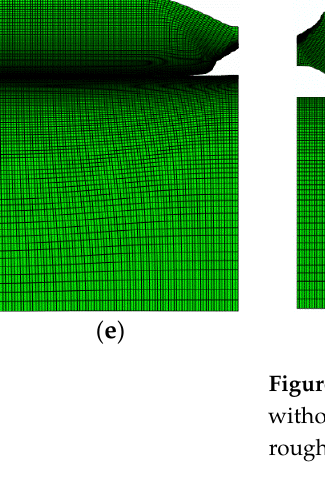
Table 5. Sequence of change in maximum traction and the final separation.